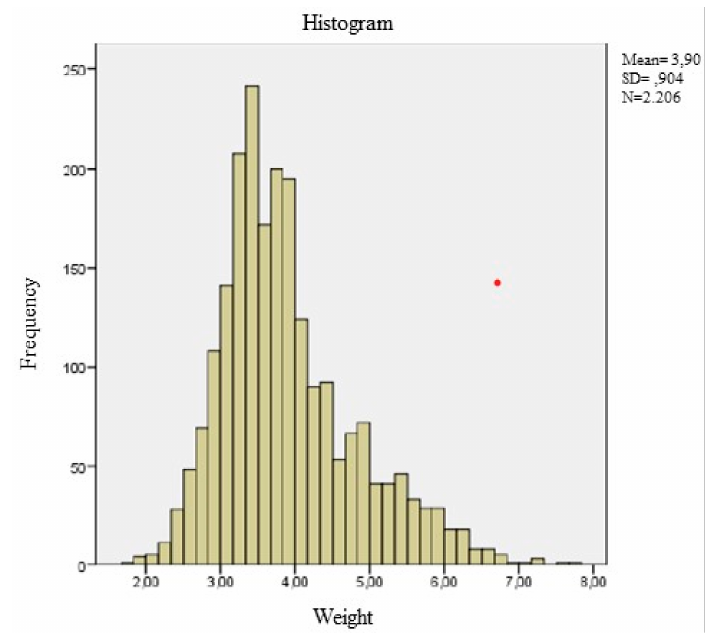
Figure 1. Distribution of the initial variable